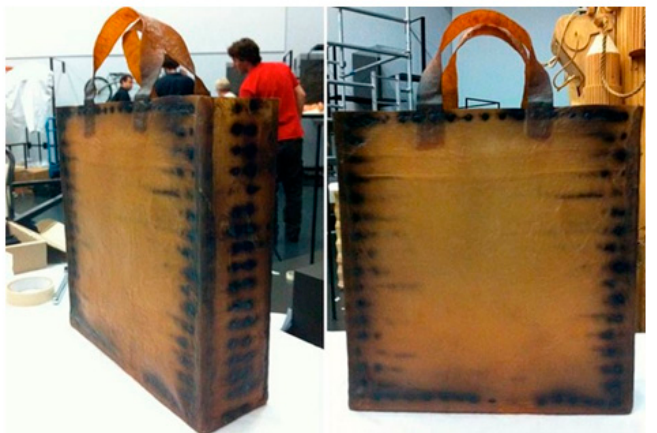
Figure 9. Biodegradable package obtained from bacterial cellulose [184].